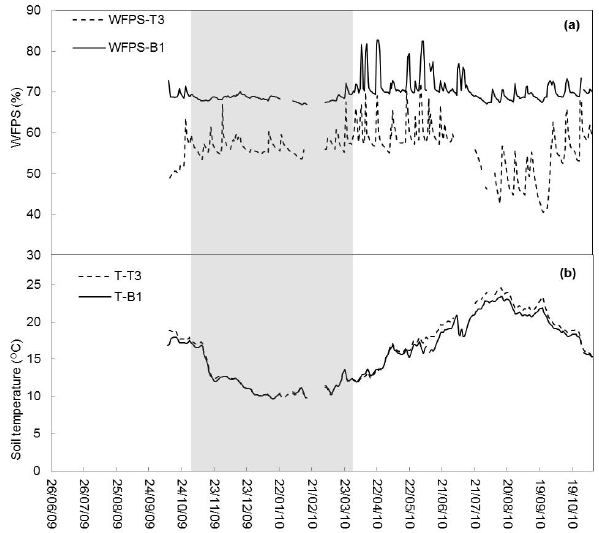
Fig. 3. (a) Soil water-filled pore space (WFPS) and (b) soil temper- ature (ST) at 10-cm depth at plots T3 and B1. Shaded area indicates the dry-cool